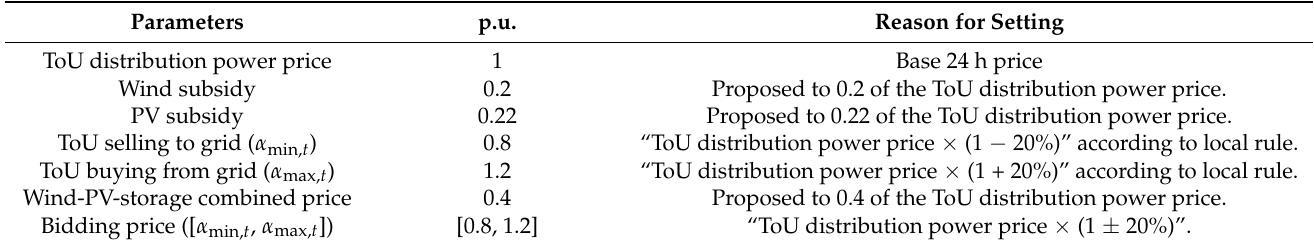
Table 3. The basic price and bidding price setting rule.